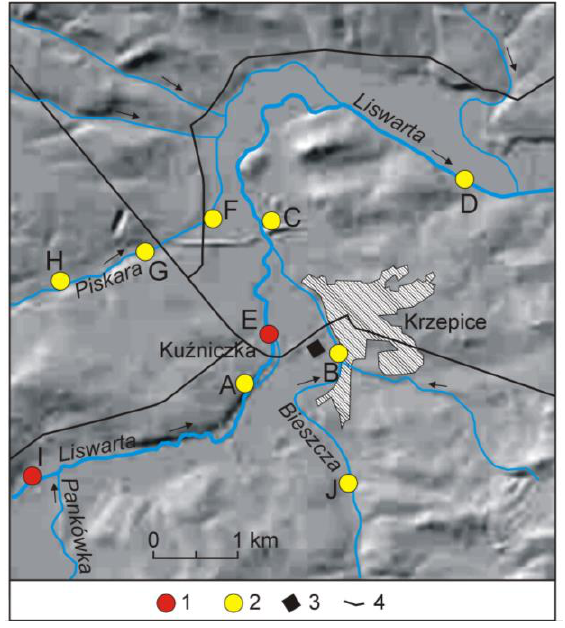
Fig. 1. Locations of the mills